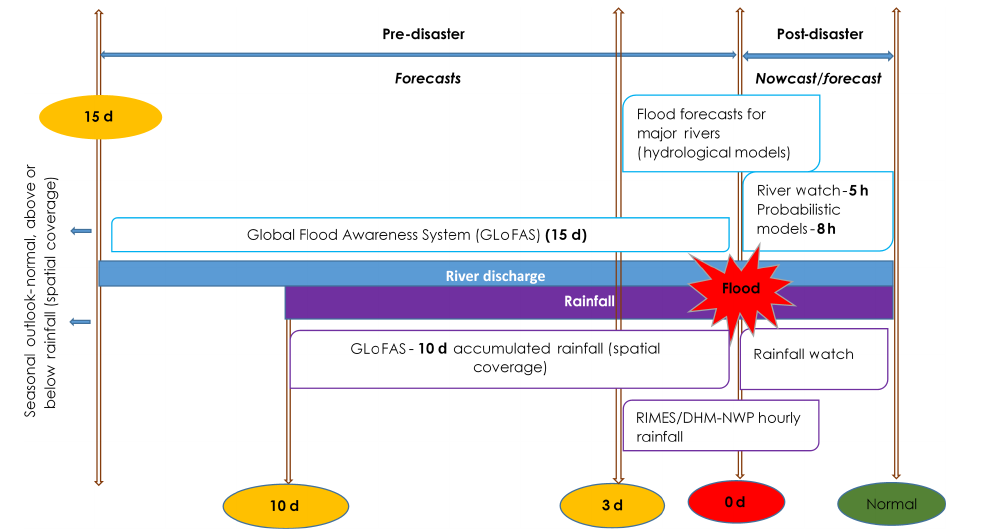
Figure 5. Diagram of lead time of forecasts in Nepal. Pre-flood event forecasts provide 15, 10 and 3d forecasts, with shorter term river level forecasts providing 5–8h of early warning.